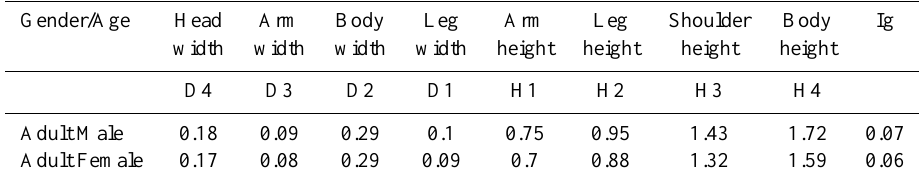
Table 2. Dimensions of the human body model derived from anthropometric data (in m). Gender/Age Head Arm Body Leg Arm Leg Shoulder Body Ig width width width width height height height height D4 D3 D2 D1 H1 H2 H3 H4 Adult Male 0.18 0.09 0.29 Adult Female 0.17